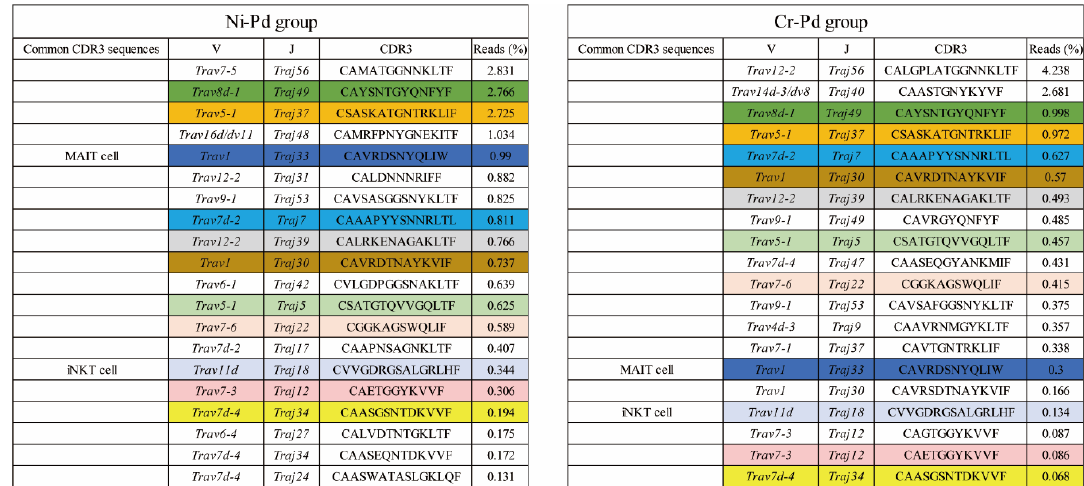
Figure 6. Distributions of the read (%) of amino acid sequences of CDR3 regions of TRAV and TRAJ in the mouse model of cross-reactive metal allergy. Amino acid sequences of CDR3 regions in the Ni-Pd and Cr-Pd groups at 7 days after the third challenge. T cells bearing Trav8d-1-Traj49 and Trav5-1-Traj37 occupied a high proportion of cells in the Ni-Pd and Cr-Pd groups. Shared T cells bearing the same TRAV, TRAJ, and CDR3 sequences colored in Figure 6 were obtained from both groups. Mucosal-associated invariant T (MAIT) cells and invariant natural killer T (iNKT) cells were also observed in both groups.